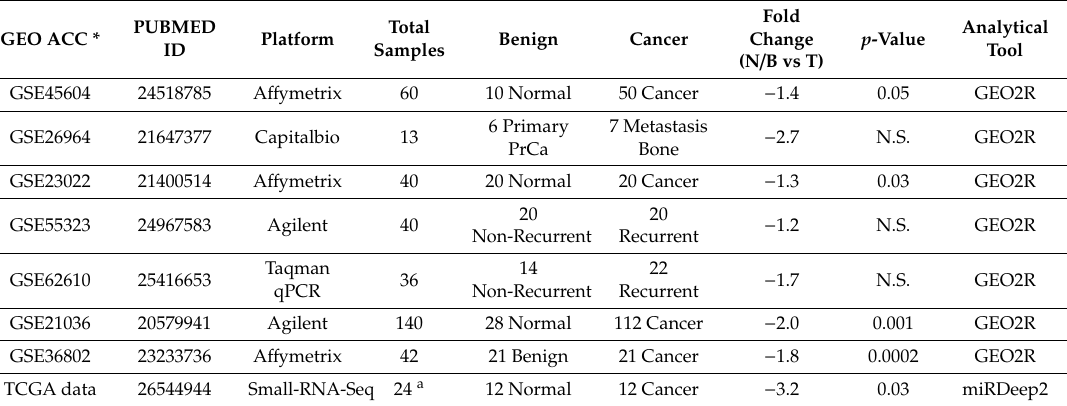
Table 1. Analysis of snc886-3p abundance in PrCa microRNA